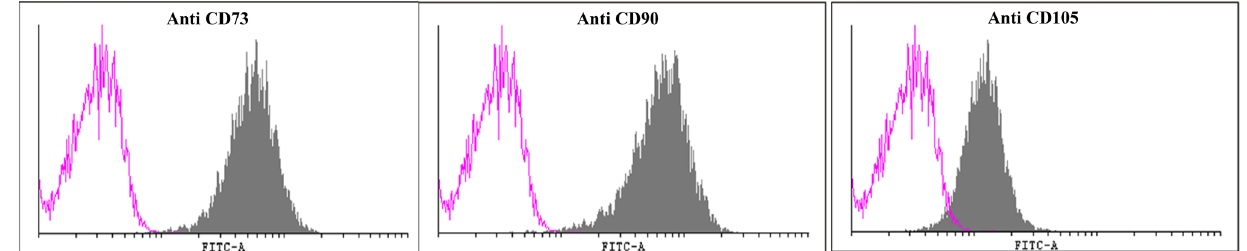
Figure 2. Flowcytometric evaluation of isolated B-MSCs with positive controls of CD73, CD90, and